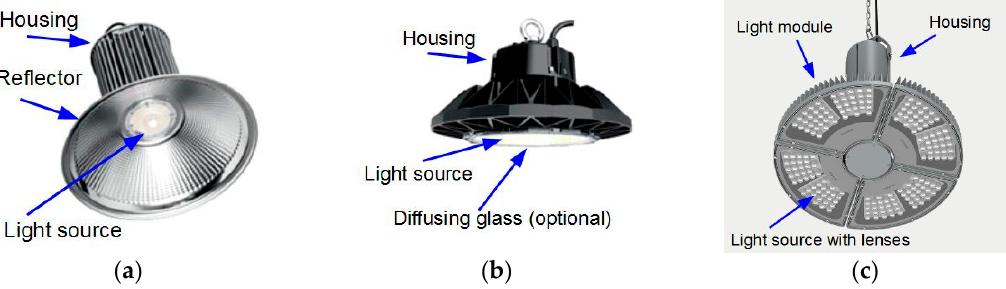
Figure 2. Selected luminaires with a rotationally symmetrical solid of light distribution and different type of optical system: ( a ) reflector type, ( b ) uncovered LED with optional diffusing glass, ( c ) lens type.